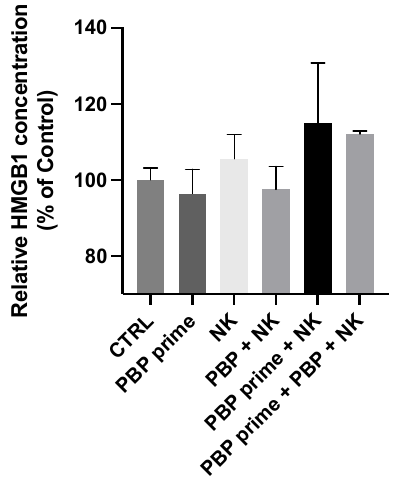
activity of NK cells; dying cancer cells secrete more HMGB1, which could lead to synergistic effects on NK-mediated cytolytic activity against cancer cells.